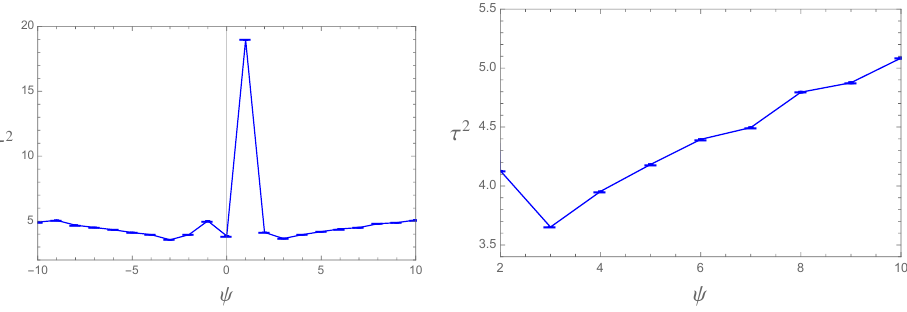
Figure 6 . The measure of second order curvature invariants (cid:28) 2 , as a function of for the one parameter family of quintics in P 4 (3.2). The expected features can be seen in the left hand plot, given the known location in moduli space of curvature singularities, are correctly reproduced. An additional small feature is also seen at = (cid:0) 1. This feature is discussed further in the text. The same data is presented in the right hand plot with the large features associated to the conifold points omitted from the plot range. The tendency of (cid:28) 2 to increase as we approach the large complex structure limit can clearly be seen.